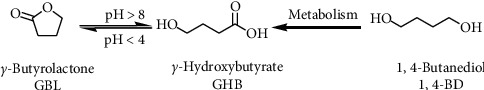
The chemical structures and transformation of GBL, GHB, and 1,4-BD.